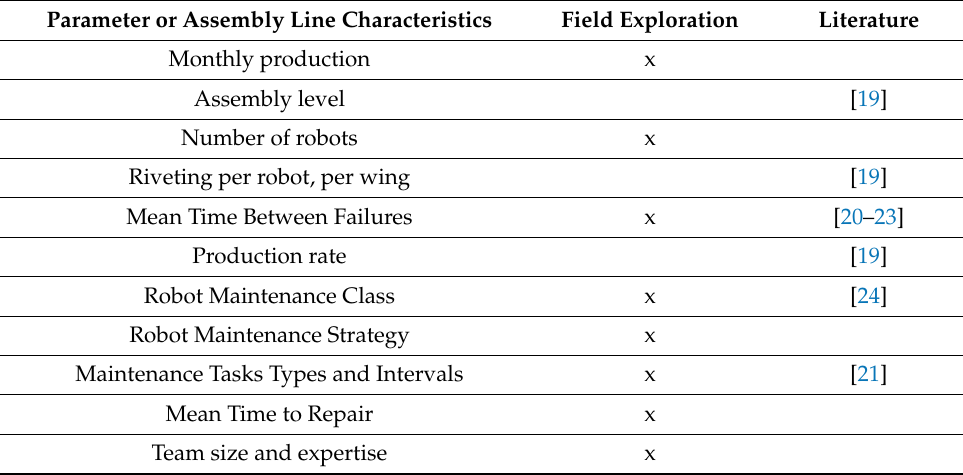
Table 1. Parameters’ sources Parameter or Assembly Line